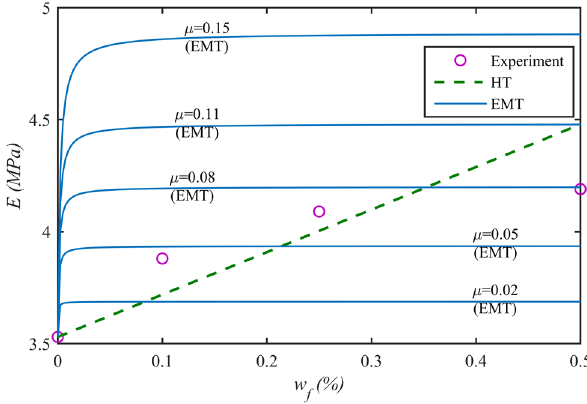
Figure 6: Young ’ s modulus of PDMS/MWCNT nanocomposite obtained from HT, EMT ( with di ff erent aggregation states ) , and experimental compression test versus MWCNT weight